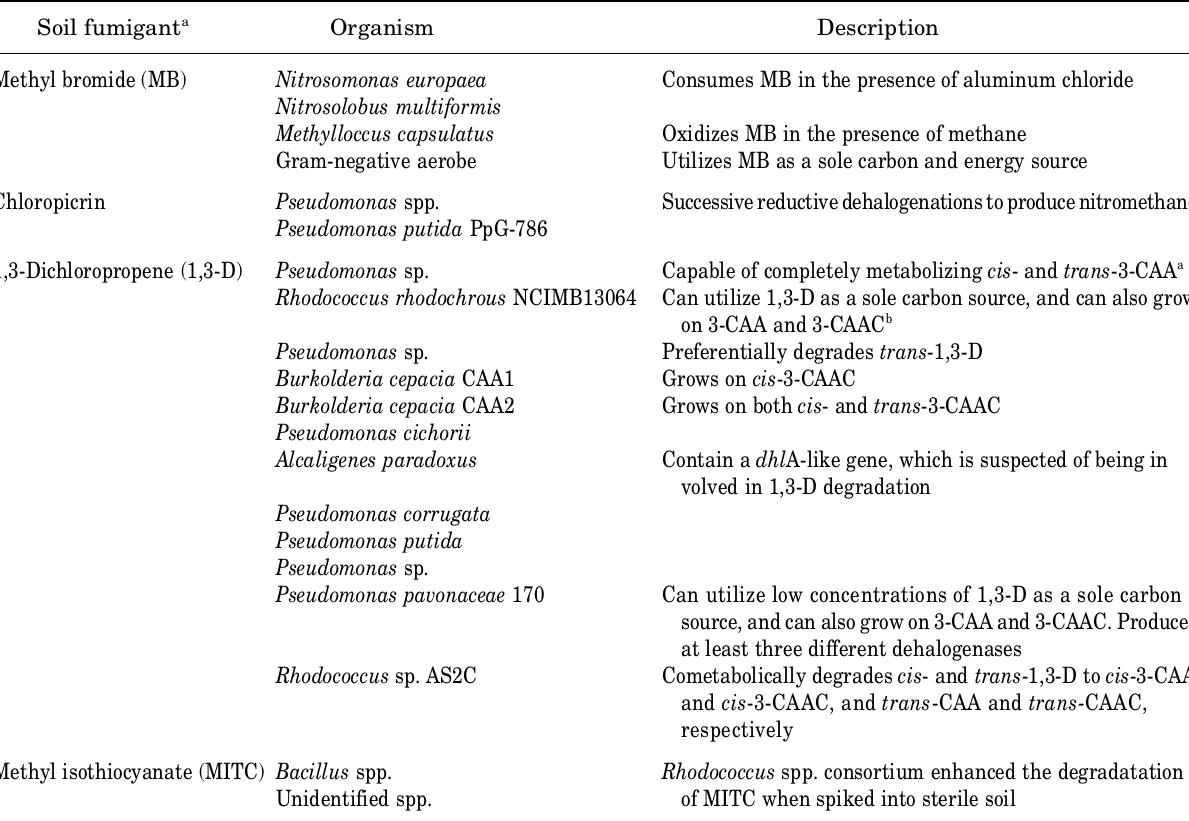
Table 4. Microorganisms linked to the degradation of methyl bromide and selected alternative fumigants in soil (Dungan and Yates,